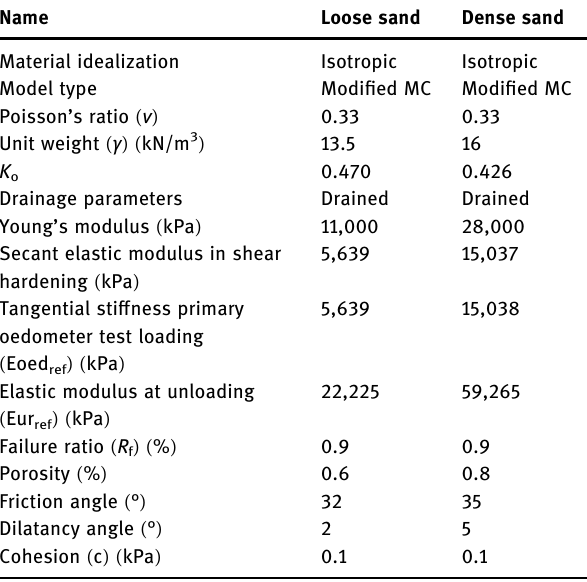
Table 1: Summary of materials used in the current